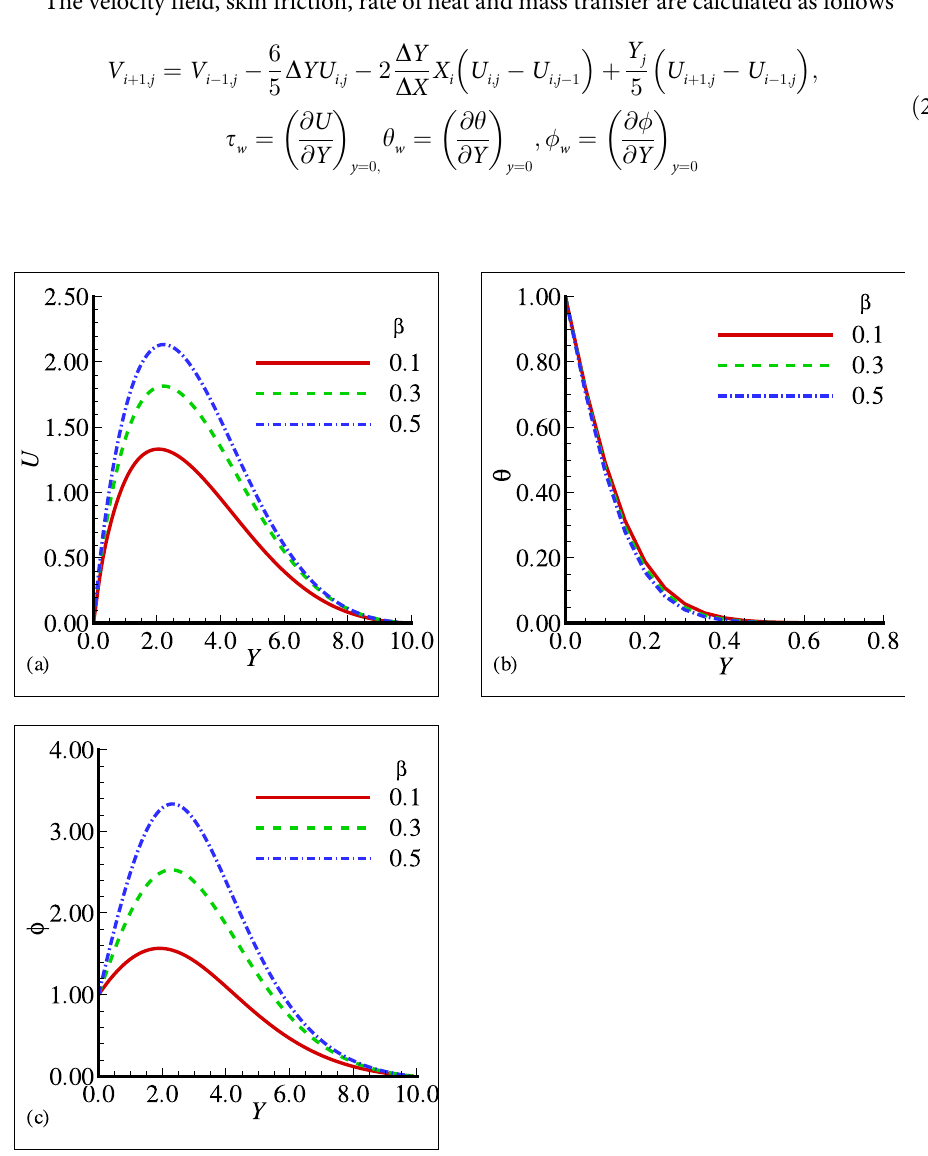
Fig 4. Profiles for (a) U (b) θ and (c) F for different exothermic parameter β with n = 0.3, Pr = 0.5, Sc = 0.4, E = 0.1, γ = 0.1, λ = 0.8, ξ = 0.4 and γ μ = 0.2.